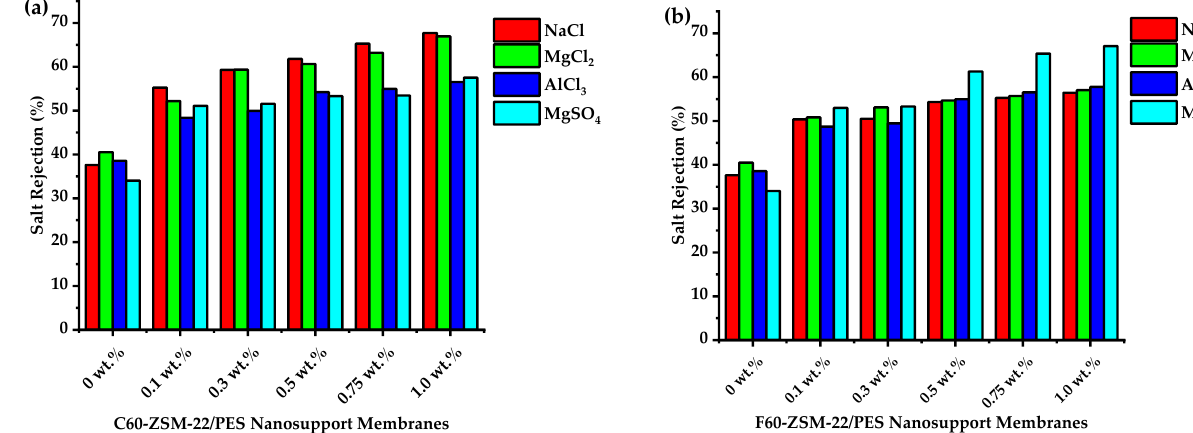
Figure 15. Salt rejection analysis of nanofiltration membranes prepared via phase inversion to nominal wt.% loadings of 0, 0.1, 0.3, 0.5, 0.75, and 1.0 using ZSM-22 zeolite as nanoadditives: ( a ) C60-ZSM-22/PES and ( b ) F60-ZSM-22/PES .